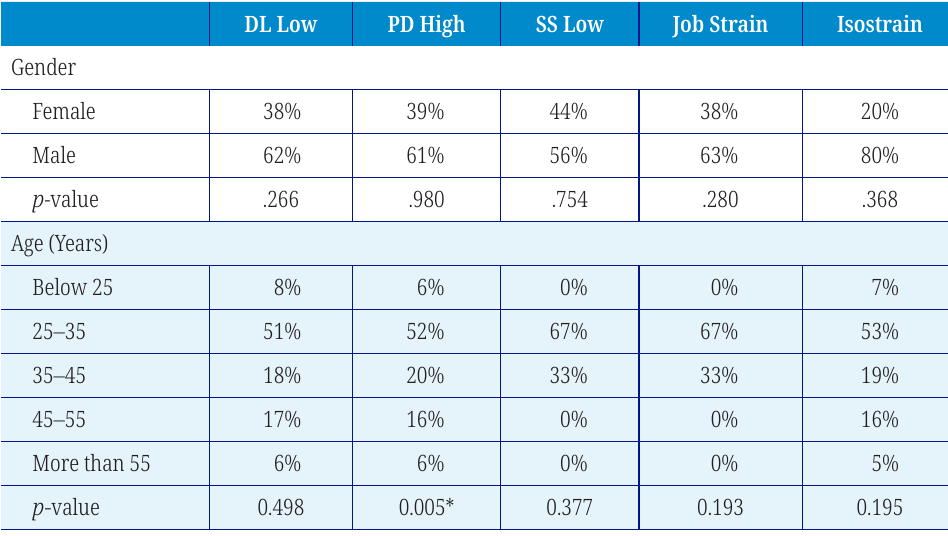
Table 4. Distribution of studied population according to gender, age, and psycho-organizational dimensions (N = 218)